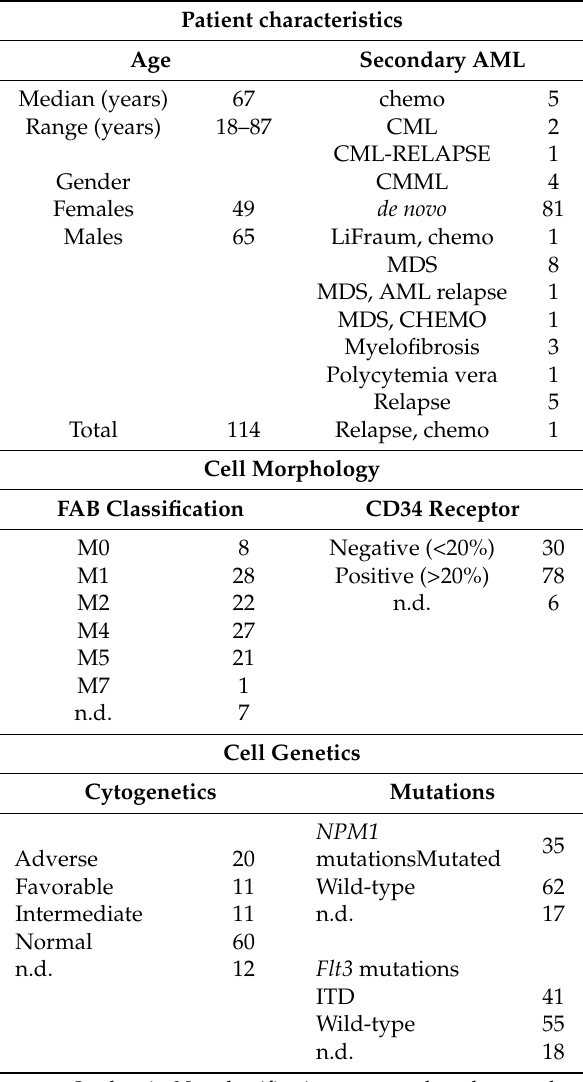
Table 2. The biological and clinical characteristics of the 114 AML patients included in the